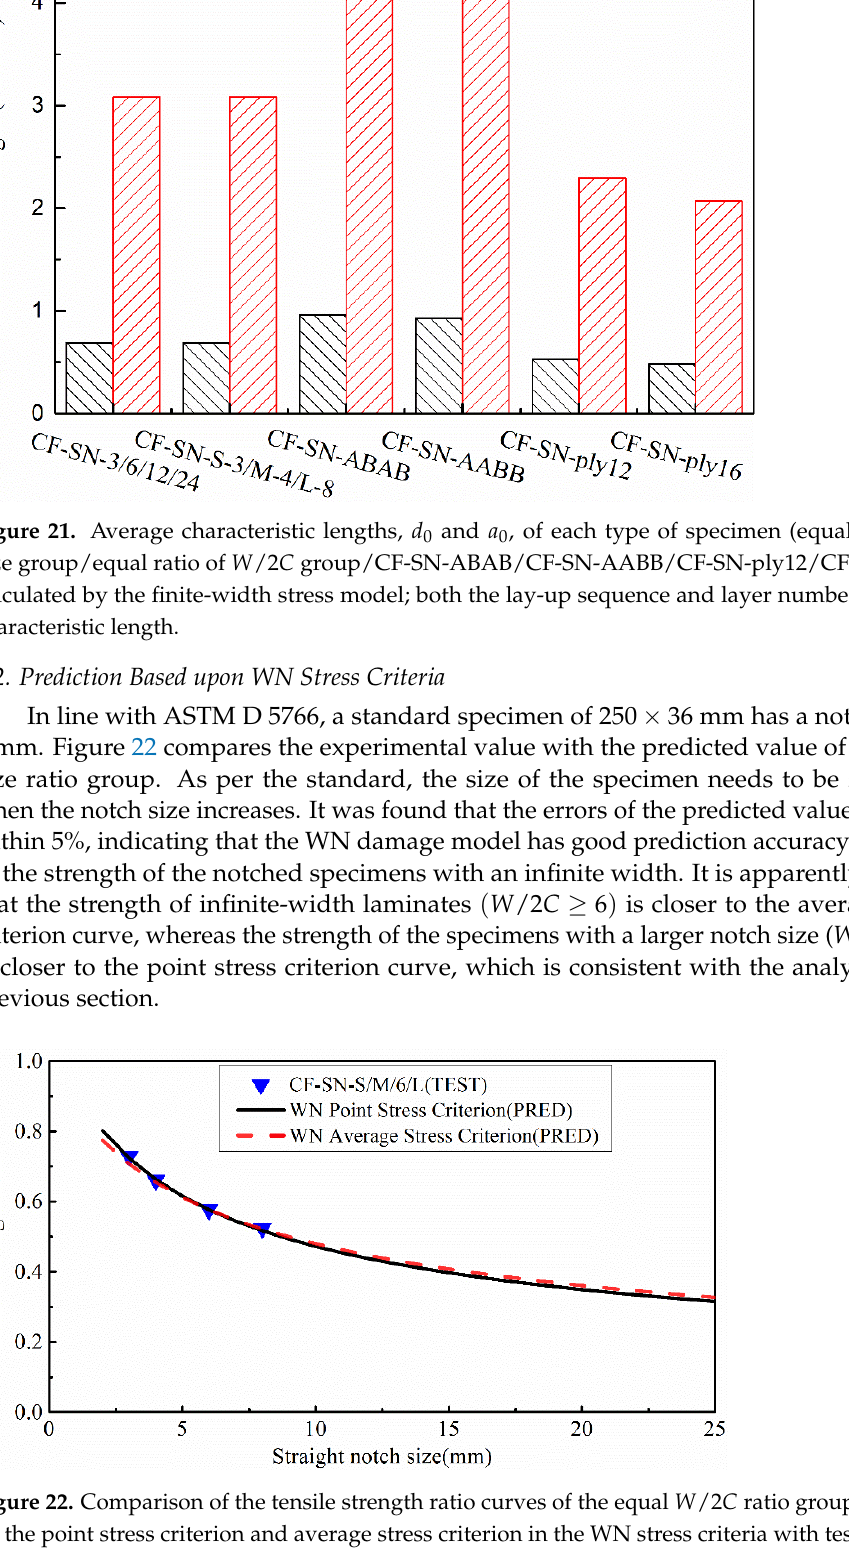
Figure 20. Average characteristic lengths, 𝑑 0 and 𝑎 0 , of each type of specimen (equal specimen size group/equal ratio of 𝑊 /2 𝐶 group/CF ‐ SN ‐ ABAB/CF ‐ SN ‐ AABB/CF ‐ SN ‐ ply12/CF ‐ SN ‐ ply16) calculated by the WN stress criteria; both the lay ‐ up sequence and layer number affect the charac ‐ teristic length.